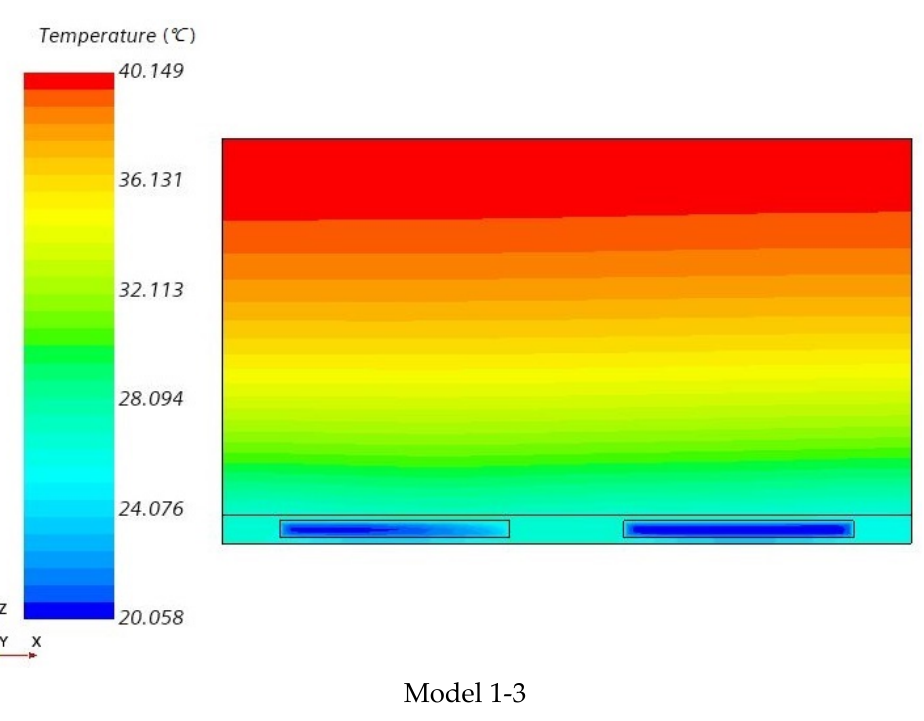
Figure 10. Temperature distributions on the cross-section area of the three modules with the bottom cooling system.